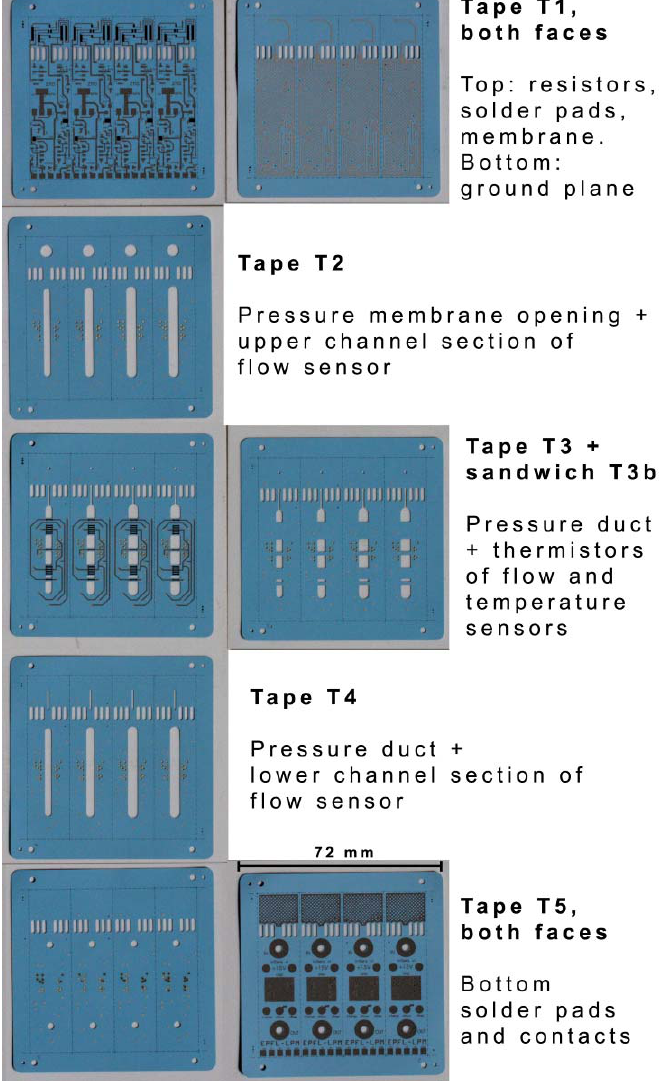
Figure 8. Top view displaying all five LTCC tapes of the integrated sensor